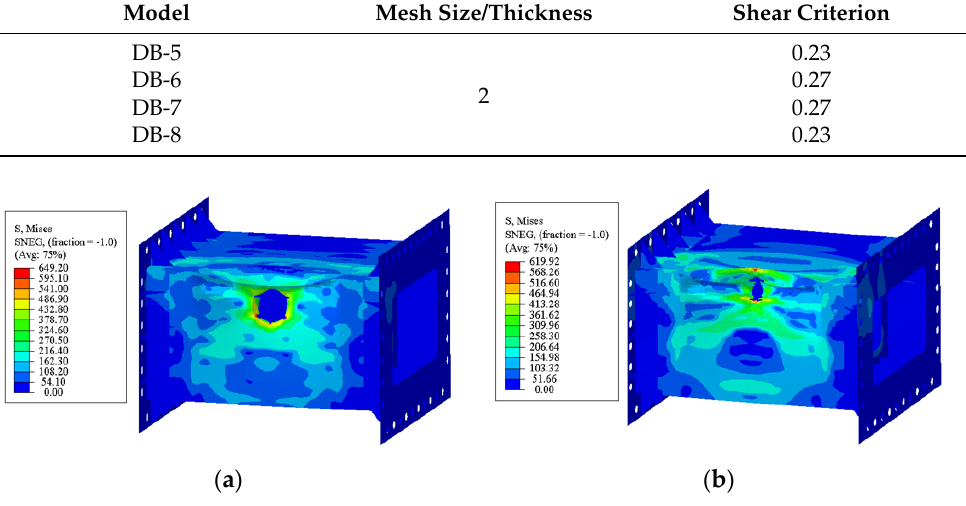
Figure 23. Fracture-damaged models after the side collision: ( a ) DB-5; ( b ) DB-7. Table 8. The comparison of the numerical predictions with the experiment results: Fracture damage. Diagonal Length (mm) Model